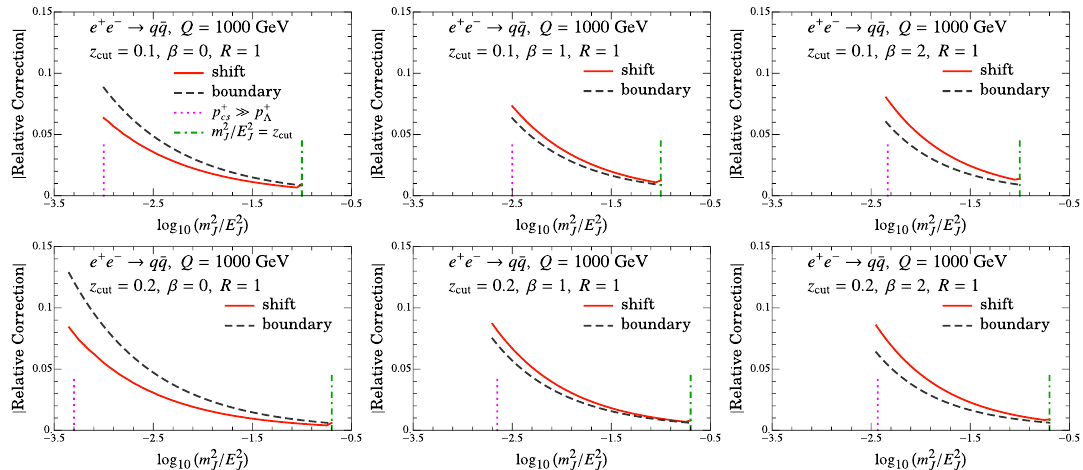
Figure 13 . Absolute value of the fractional power correction induced by the leading nonpertur- bative shift and boundary corrections, choosing for illustration (cid:10) (cid:14)(cid:14) (cid:7) 1 ; 1 = 0 : 4 GeV. The vertical lines as in (cid:12)gure 2 indicate the extent of the SDOE region, as labeled in the top left